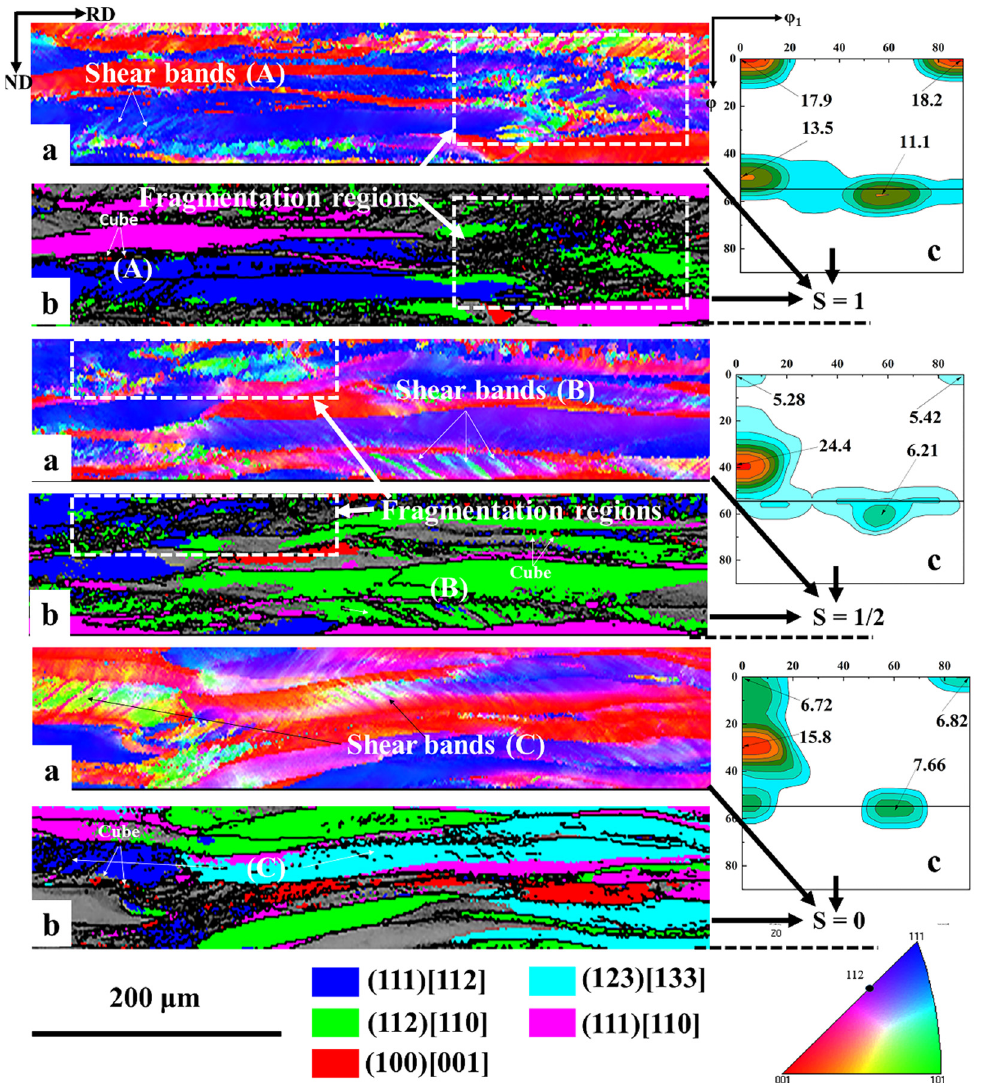
Figure 12. Microstructure and texture after asymmetric rolling. ( a ) EBSD inverse pole figure map; ( b ) image quality map showing orientation within the deformed matrix and shear bands; ( c ) texture ( φ 2 = 45° section, Bunge notation.